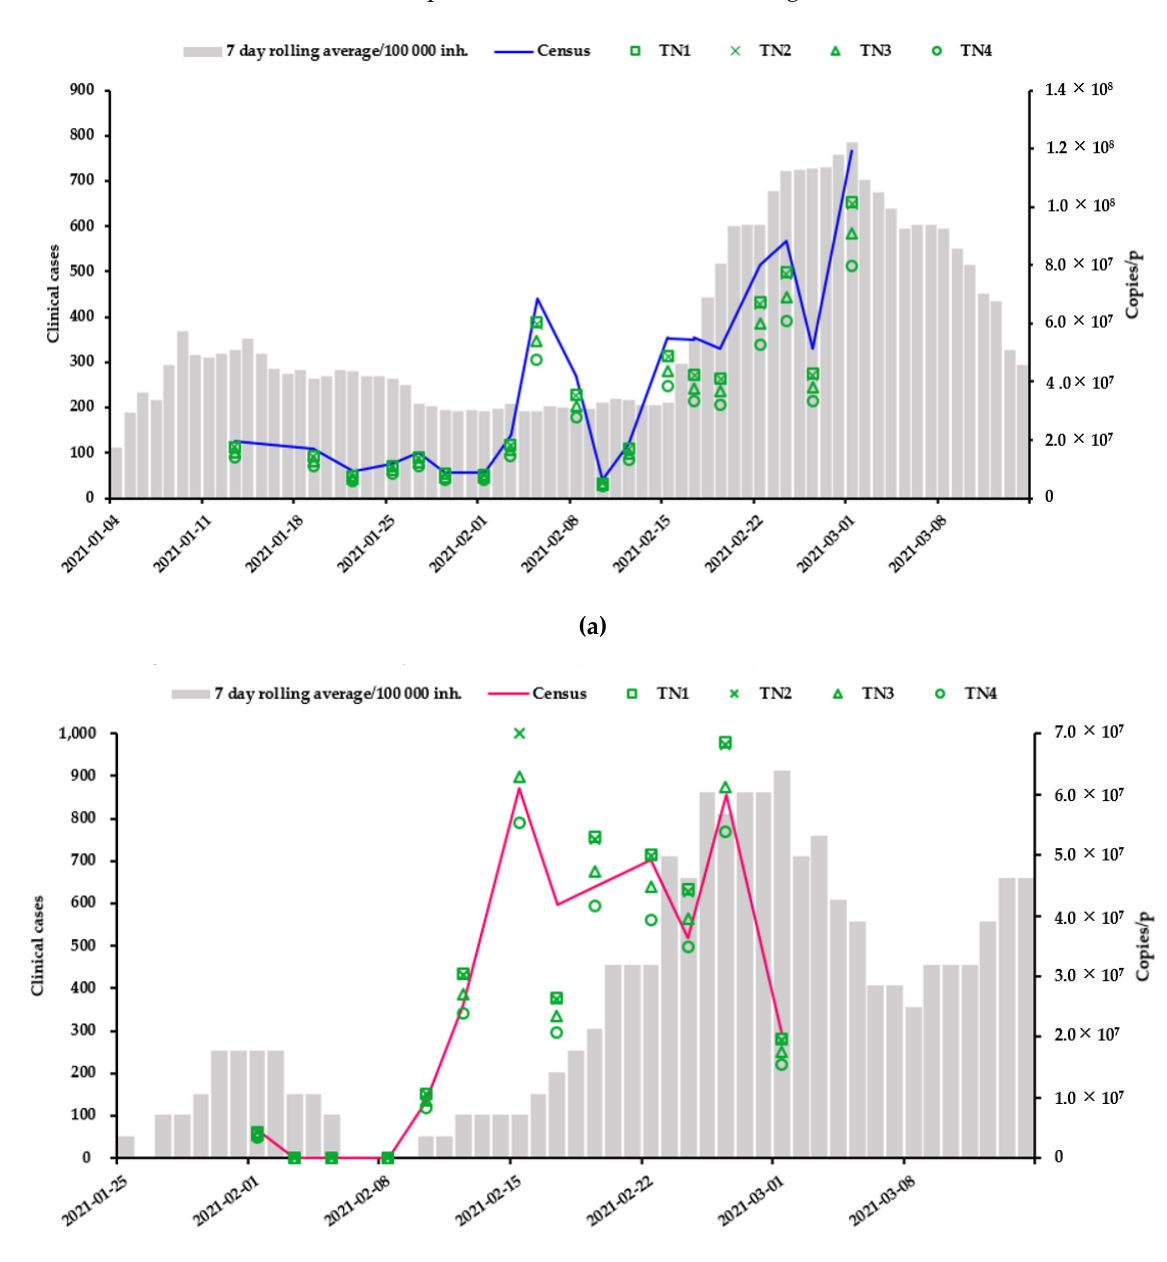
Figure 4. Longitudinal data of SARS-CoV-2 viral loads (copies/d) normalized to census population (census) and TN estimated population size (TN1-TN4 benchmarked with daily new clinical cases per 100,000 inh. based on day of testing at ( a ) UDD WWTP and ( b ) RAN WWTP (note: the date identified is the first Monday of every week).